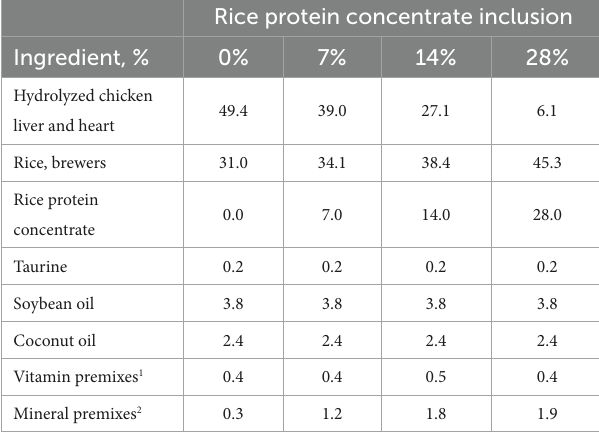
TABLE 2 Select ingredients included in test foods containing increasing levels of rice protein